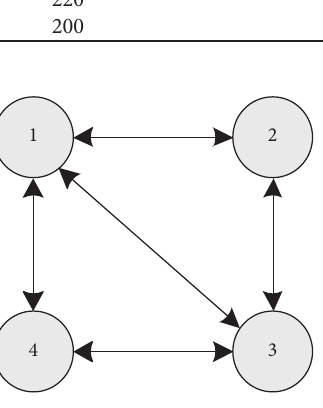
Figure 2: Undirected and connected communication topology among vehicles.